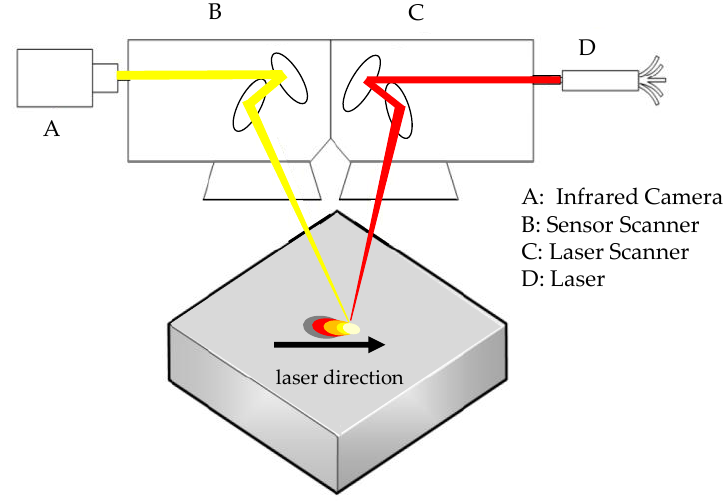
Figure 4. Schematic setup of Synchronized Path Infrared Thermography (SPIT). The measuring field of the camera ( A ) is moved by the sensor galvanometer scanner ( B ) synchronously with the working galvanometer scanner ( C ) of the laser ( D ).